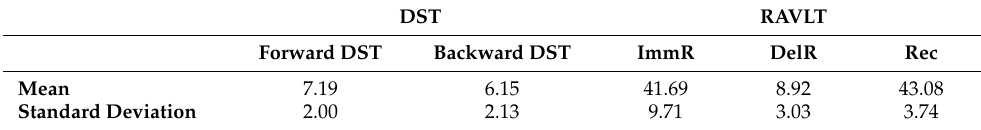
Table 2. Participants’ scores statistics.